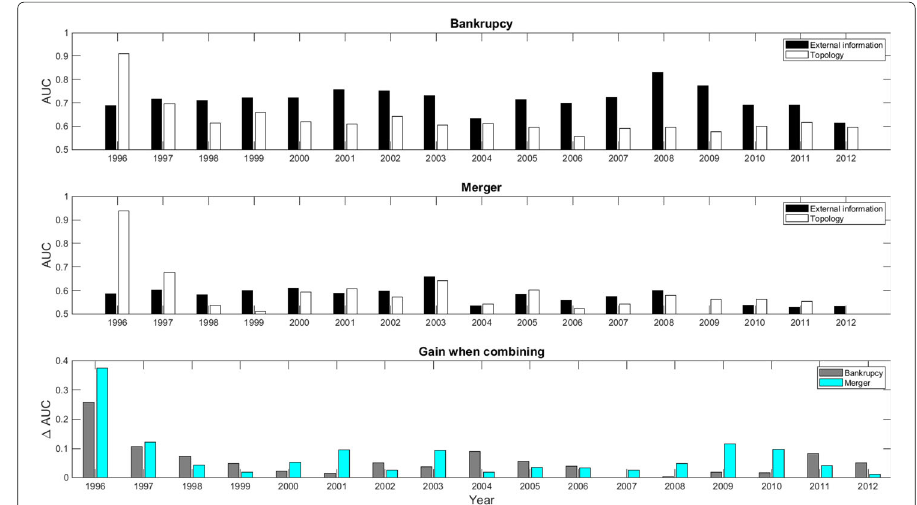
Fig. 10 (Upper and Middle) Comparison of AUC for logistic regression on external features and Random Forest Classifier on topological features for both bankruptcy and merger companies, respectively. (Bottom) The gain in AUC for Random Forest on combined topological and external features for the bankruptcy and merger